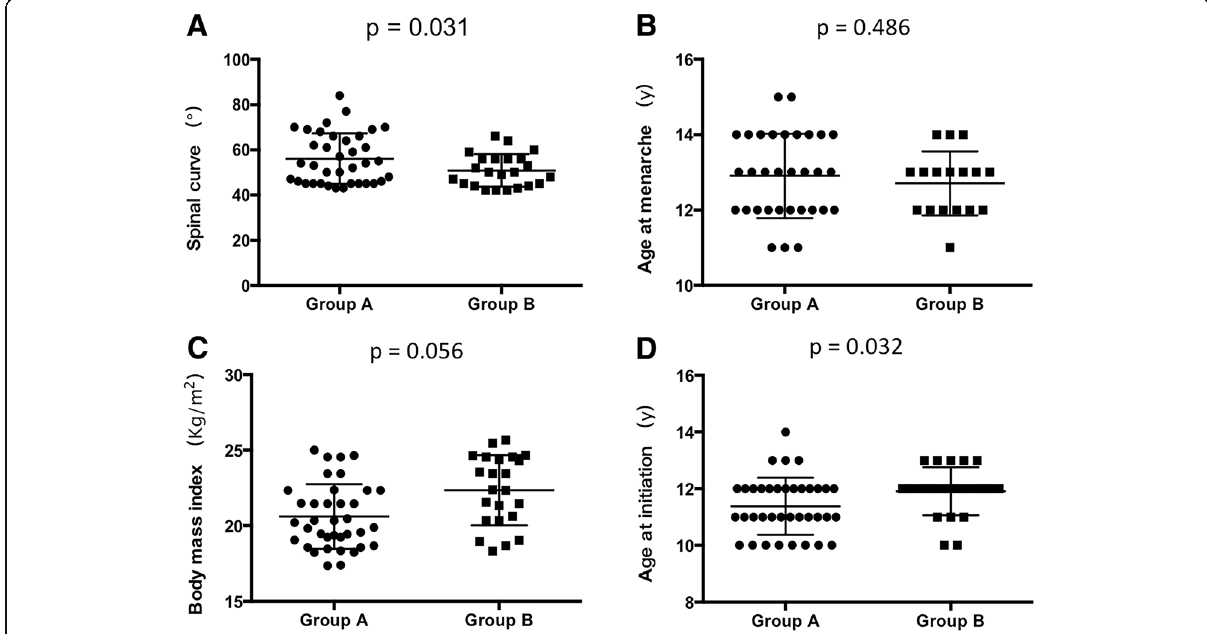
Fig. 3 ADIPOQ mRNA and H19 expression pattern in paravertebral muscles of AIS patients is associated with curve severity and age at initiation. Patients with lower H19 and higher ADIPOQ mRNA expression levels in concave-sided muscles were included in Group A ( n =37), and the remained patients were included in group B ( n =23). For ( a ), Patients in Group A showed a bigger spinal curve ( p =0.031) compared with patients in Group B. For ( b ), Group A and Group B showed no difference in age at menarche ( p =0.486). For ( c ), Patients in Group A tended to have a declined body mass index (BMI) ( p =0.056). For (D), Patients in Group A ( n =37) showed an earlier age at initiation ( p =0.032) compared with patients in Group B ( n